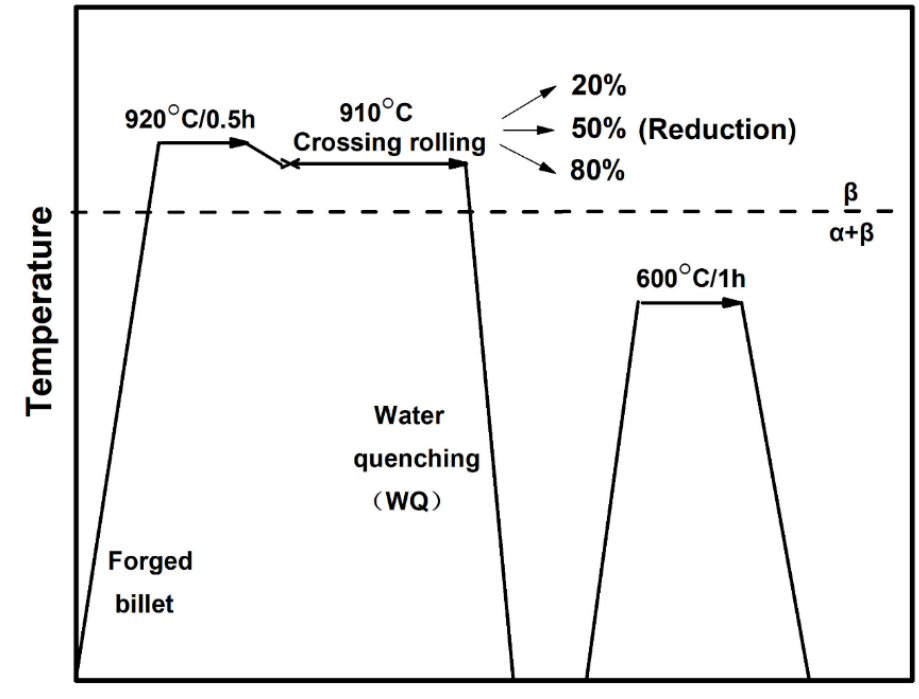
Figure 1. Schematic illustration of processing routes.